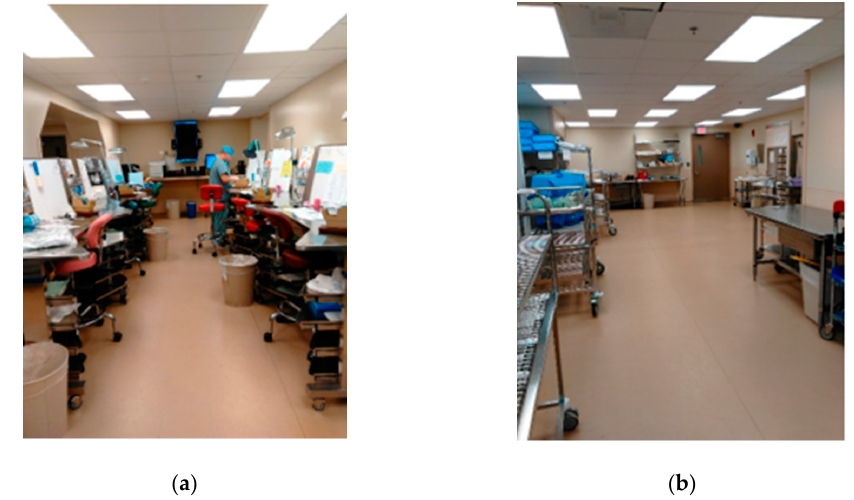
Figure 13. After Kaizen Event (KE): ( a ) Workstation type 1, ( b ) Space in front of the steam machines.